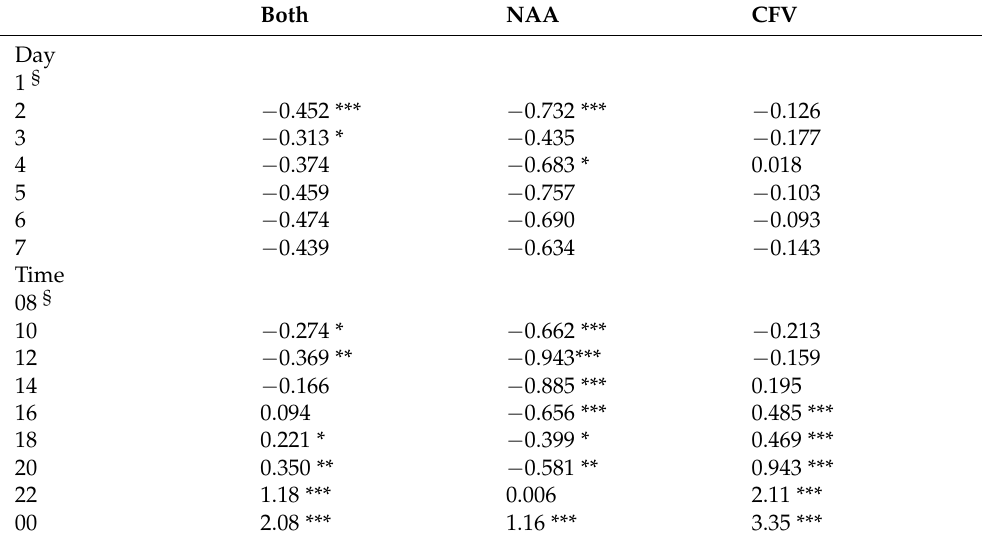
Table 4. Unstandardized beta coefficients for Karolinska Sleepiness Scale scores throughout